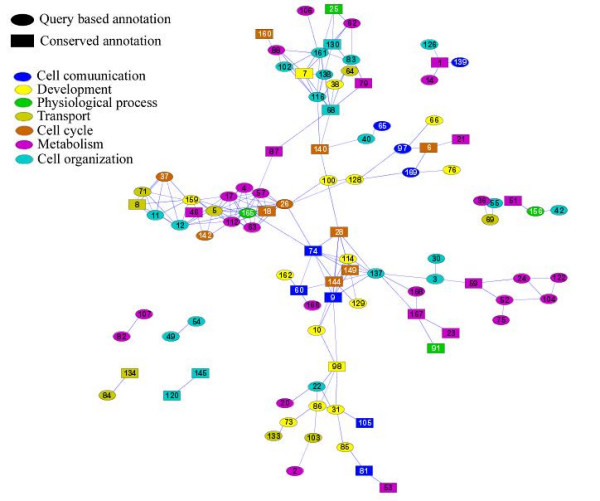
Fly best-match pathway map. A map of yeast best-match pathways in fly. Nodes represent best-match pathways and edges connect pathways that share at least two proteins. Each node is colored according to the enriched function of the corresponding query pathway in yeast. Pathways whose predicted annotation is also enriched among their constituent proteins appear as boxes; all other pathways appear as ellipses. Specific pathways can be looked up according to their number in the supplemental website [19].